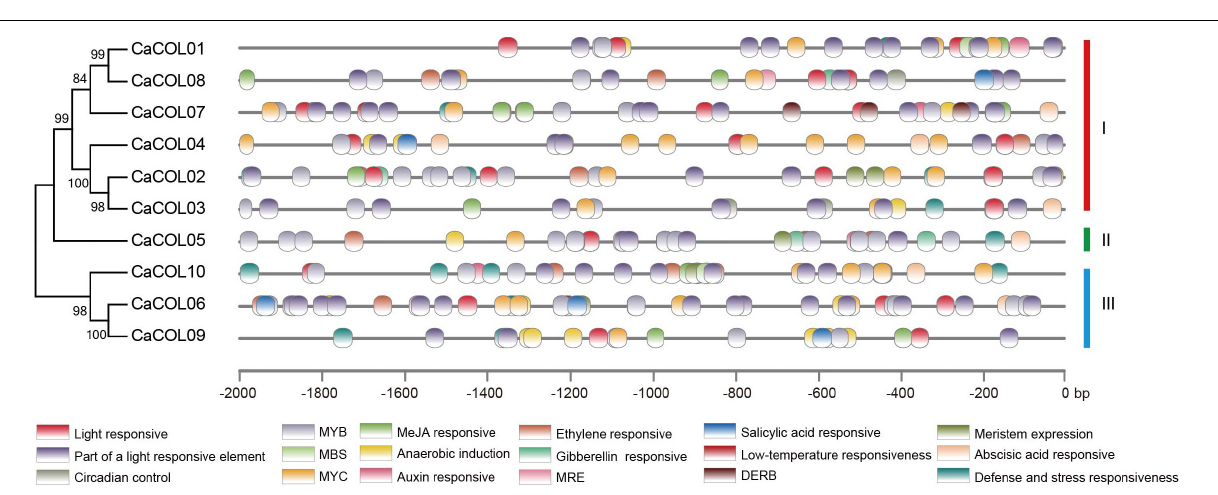
two clades. The first clade included CaCOL01 , CaCOL07 ,